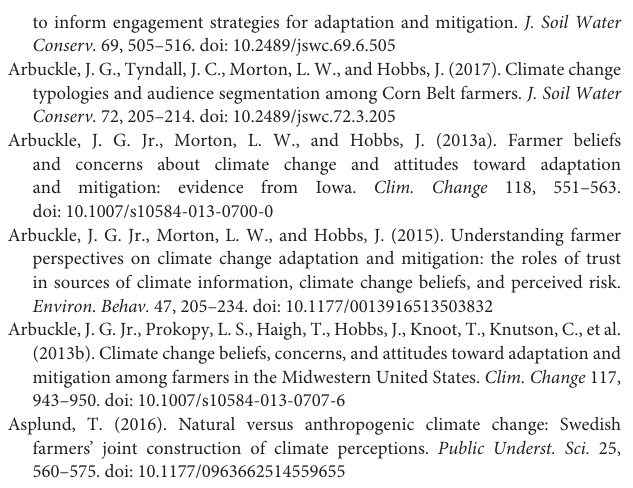
Supplementary Table 1 | Table for Research question